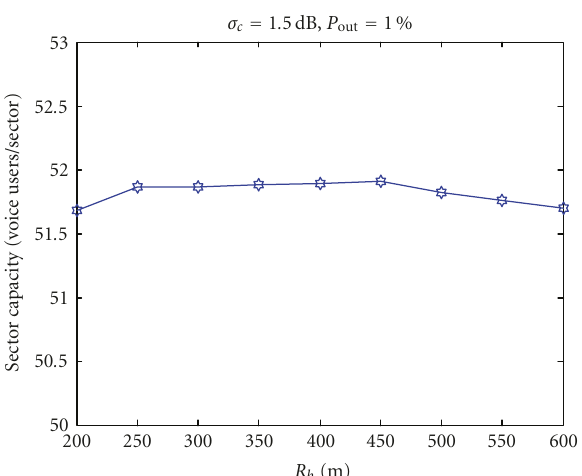
Figure 12: E ff ect of the propagation exponent γ 1 on the sector up- link capacity.